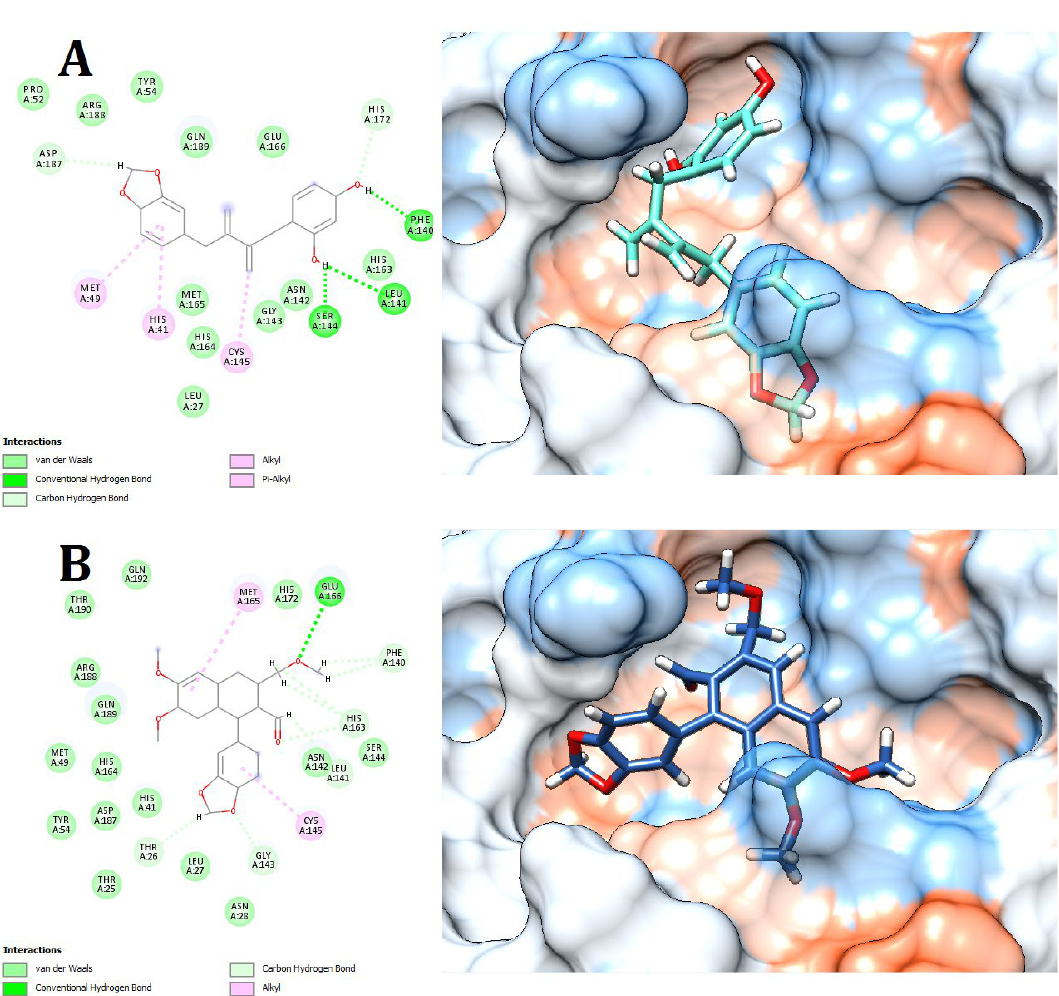
Figure 8. Docking pose visualization for the plant compounds with the best predicted results (Right) and their 2D receptor-ligand interaction diagram